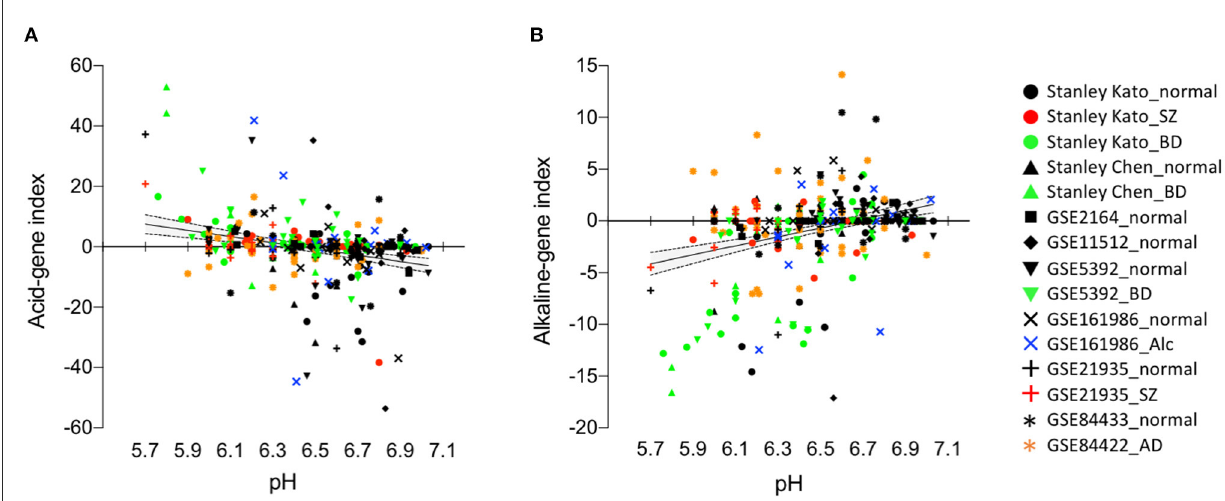
FIGURE2 Acid-gene index and alkaline-gene index correlate with actual tissue pH on an individual basis. Scatter plots showing correlations between acid-gene index and tissue pH (A) and between alkaline-gene index and tissue pH (B) . Each plot represents a single subject. Regression line (solid line) and 95% confidence intervals (dashed line) are